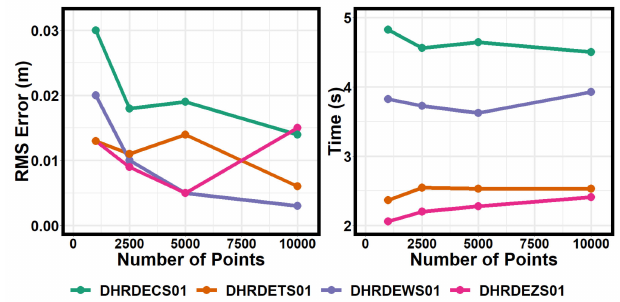
Figure 14. The experimental results.